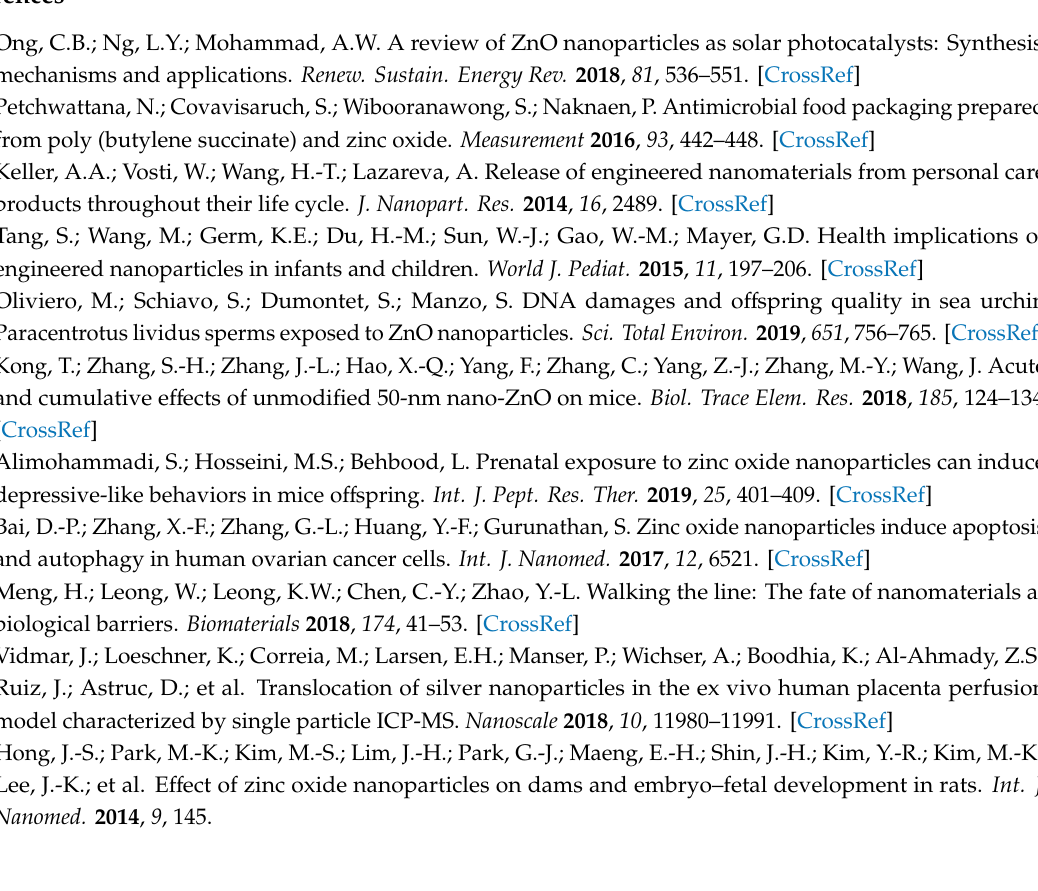
Figure S1: Organ coe ffi cient from female mice treated with various dosages of ZnO nanoparticles and control. All the data are expressed as the mean ± SD. * p < 0.05, ** p < 0.01 vs. control (n = 6); Figure S1: Hormone content in serum. (A) FSH, (B) Prog. All the data are expressed as the mean ± SD. * p < 0.05, ** p < 0.01 vs. control (n = 3); Table S1: Whole blood analysis from female mice treated with various dosages of ZnO nanoparticles and control. Author Contributions: B.C., W.H., and P.Y. conceived and designed the experiments; W.H., B.C., Y.T., and Y.Z. performed the experiments; Z.P.A. and H.X. analyzed the data; B.C., W.H., and H.X. wrote the paper. All authors have read and agreed to the published version of the